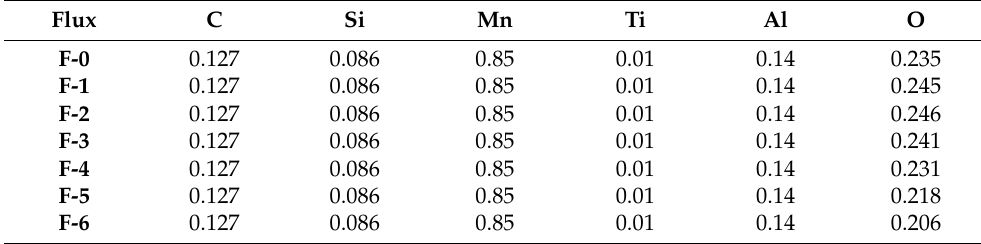
Table 4. Nominal composition considering droplet dilution and evaporation (wt